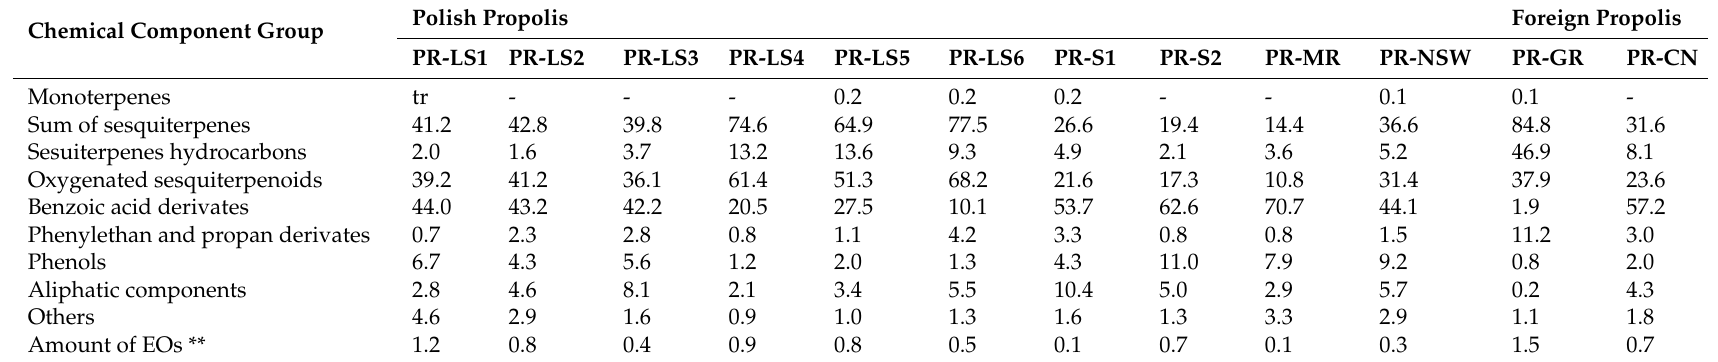
Table 4. General composition of Canadian, German and Polish propolis essential oils